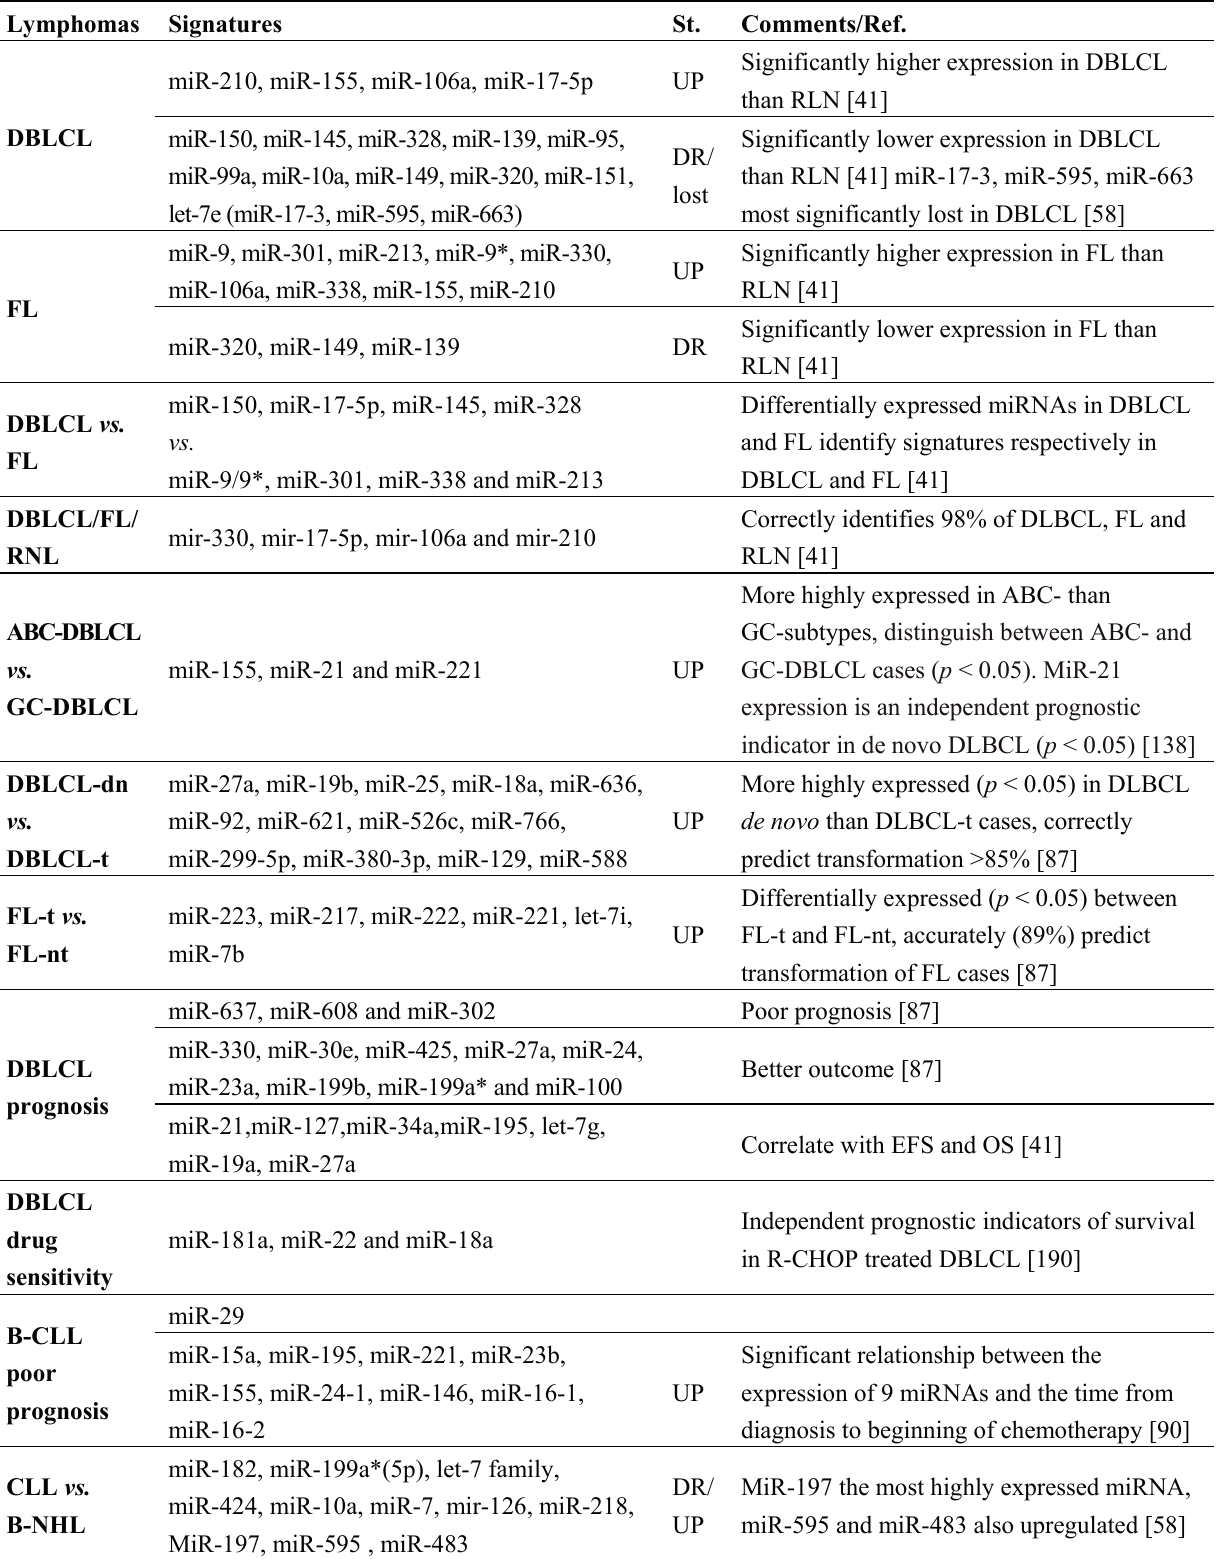
of Akt activity after over-expressing miRNA-17-92 after irradiation. This suggested miR-17-92 as novel target molecule to enhancing radiotherapy sensitivity of MCL in clinic [152] (Table 4). Table 4. Some specific miRNA signatures lymphoma-associated or treatment response correlated. Lymphomas Signatures